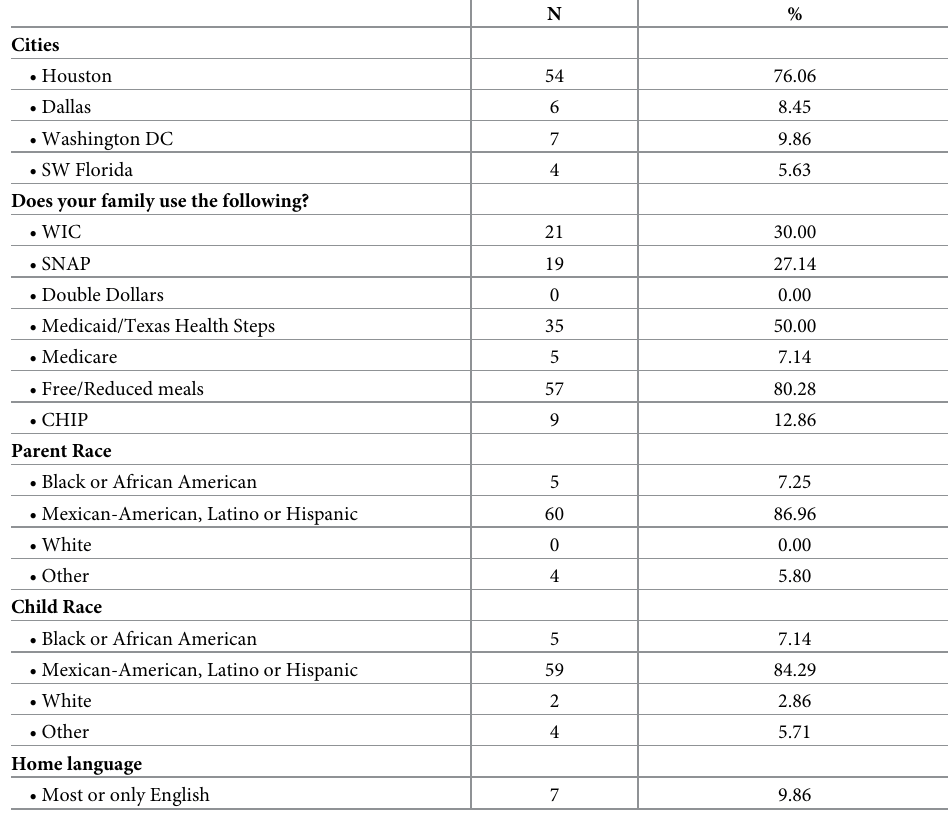
Table 1. Sociodemographics, social needs, and health status of high-risk families (n = 71), Brighter Bites COVID- 19 response survey.